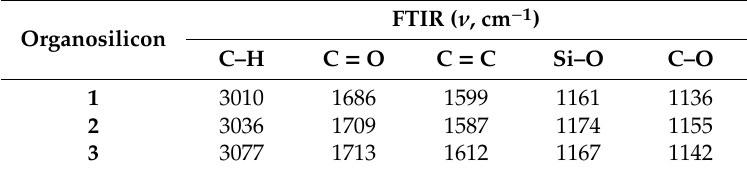
Table 1. Common FTIR absorption bands of organosilicons 1–3 .